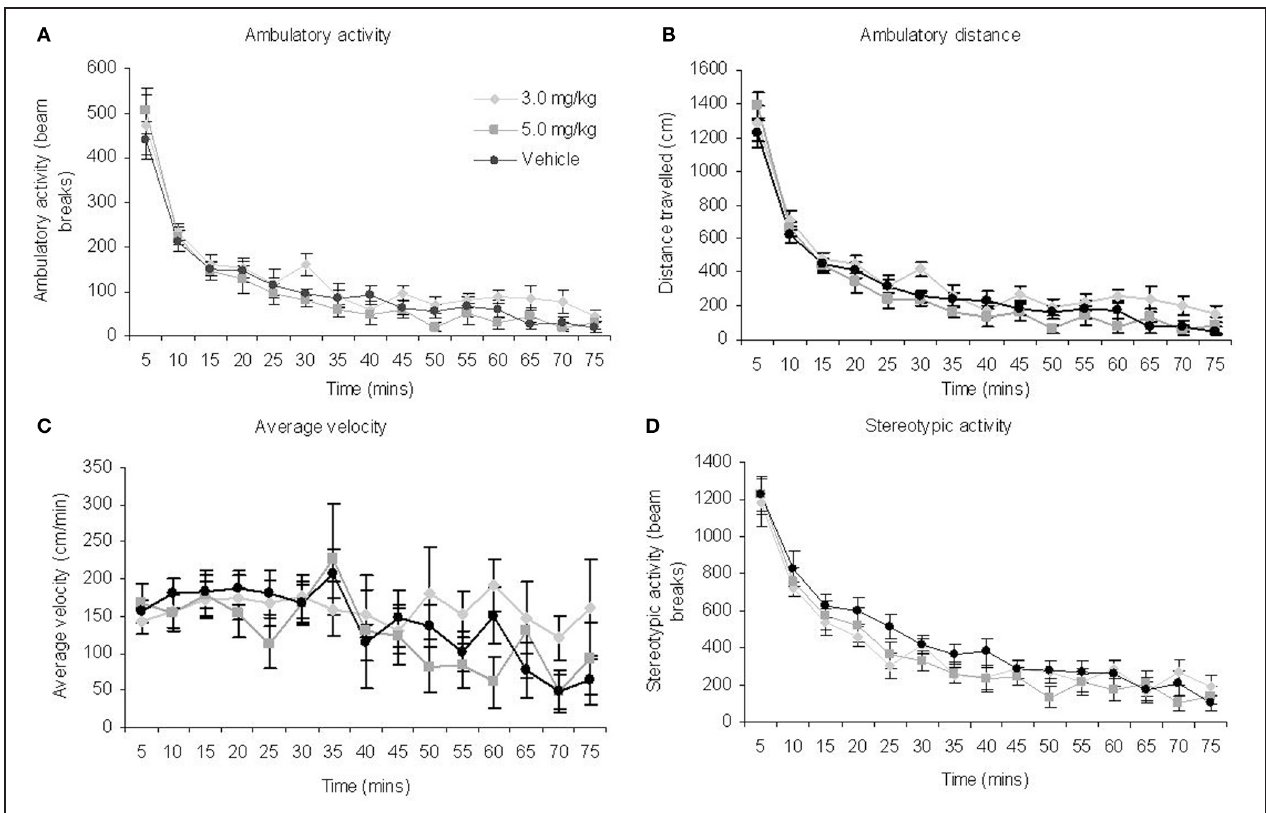
FIGURE 3 | There were no effects of MPH on measures of locomotor activity (A) ambulatory activity (B) ambulatory distance (C) average velocity (D) stereotypic activity for the animals that completed the